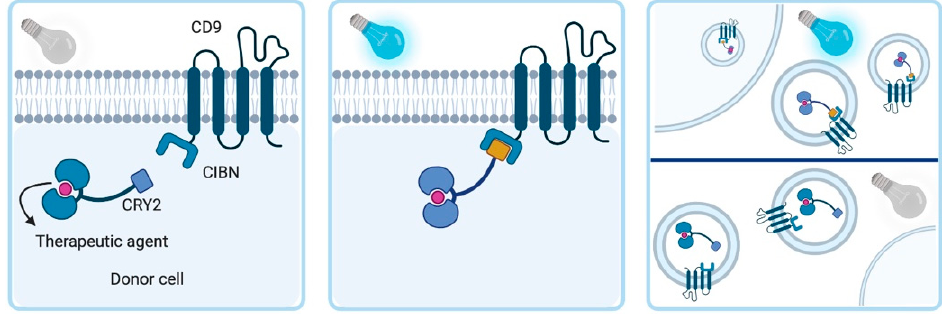
Figure 2. Principle of the EXPLORs technique. The binding between the CD9 complex and the CRY2 coupled to the therapeutic protein is induced in the donor cell by exposure to blue light (488 nm). Within 15 s, the cargo-protein is guided to the inner surface of the cell membrane and binds to the CIBN. The secreted EVs can be isolated, purified, and used for therapeutic purposes. Abbreviations: CIBN: truncated version of CRY-interacting basic-helix-loop-helix 1 (CIB1) protein; CRY2: Cryptochrome 2.